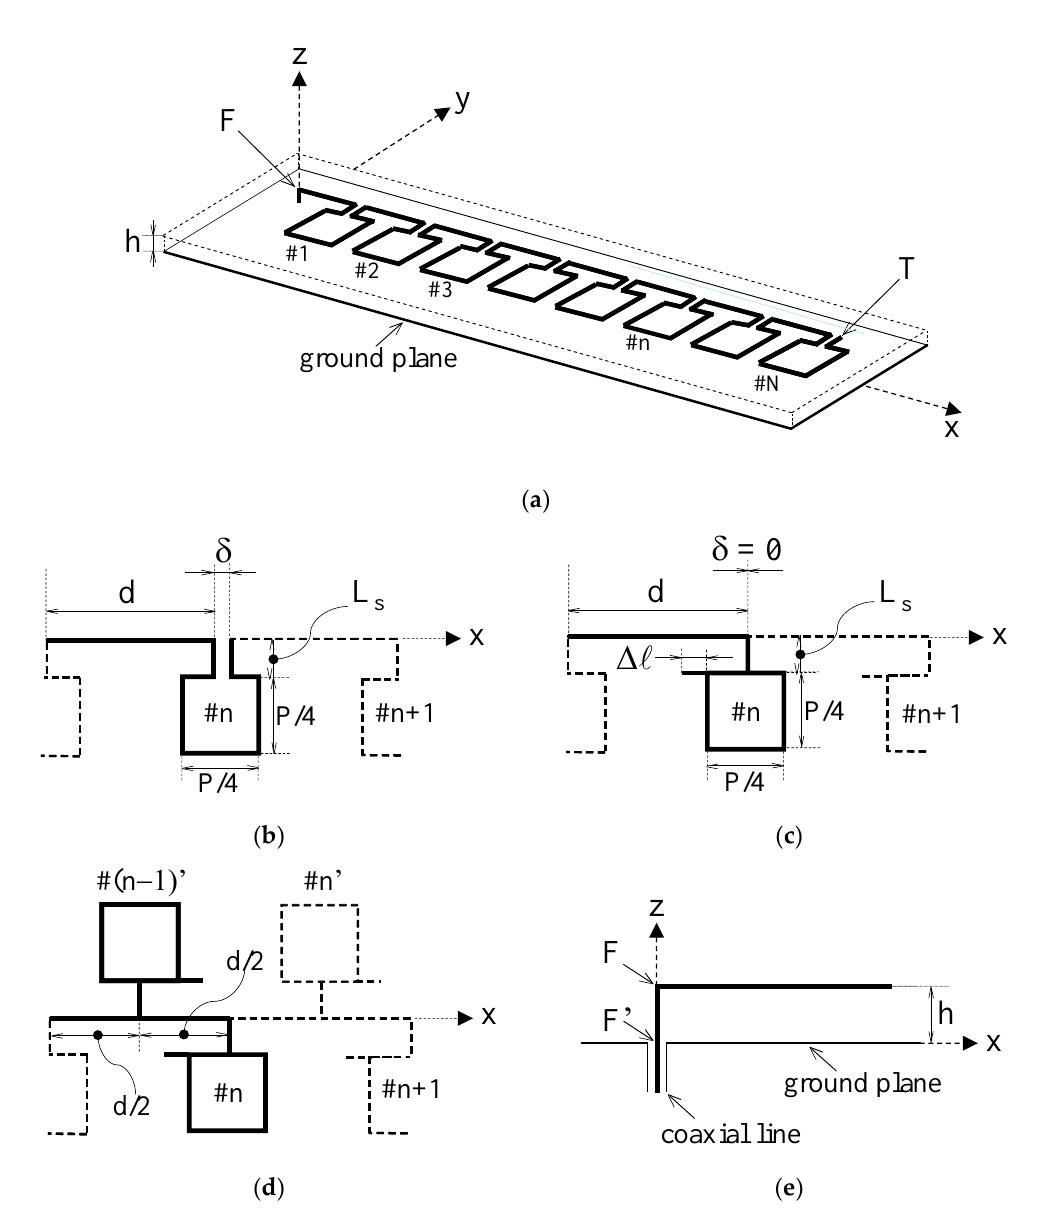
Figure 1. Antenna configurations: ( a ) perspective view; ( b ) bent line antenna having loops with a gap δ ; ( c ) branched line antenna having loops without a gap ( δ = 0); ( d ) modified branched line antenna with additional loops # n ′; ( e ) side view with a vertical wire F - F ′.